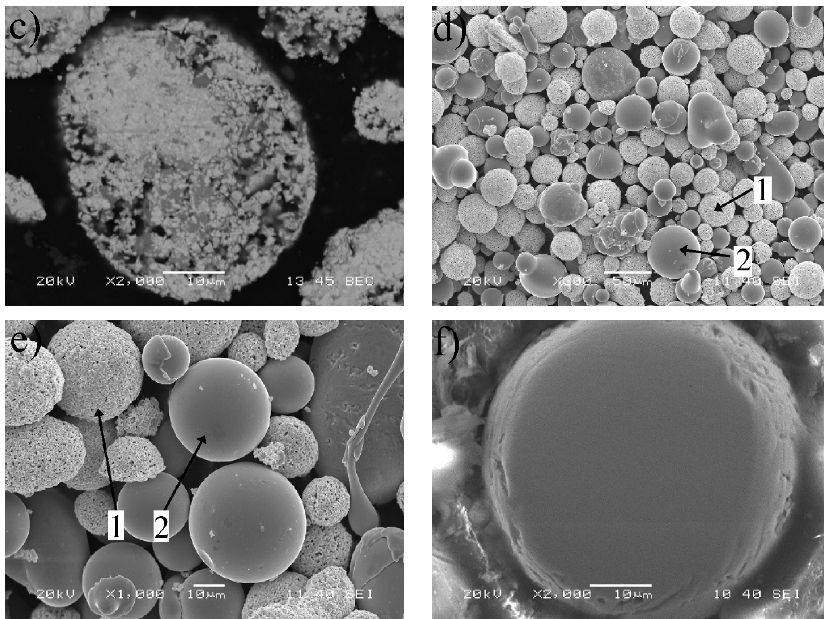
Figure 1. SEM images from morphology and cross-section of ( a – c ) WC–CoCr powder, ( d , e ) mixture